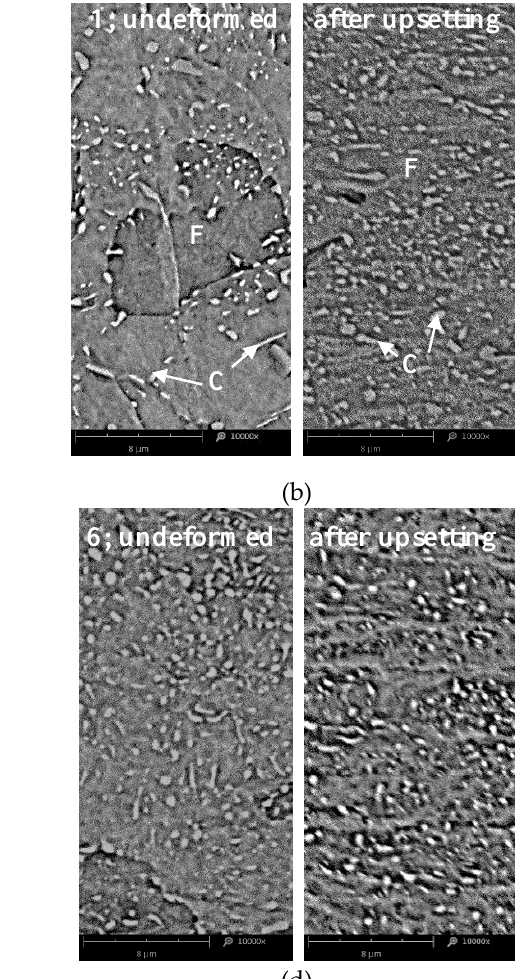
Figure 5. Transverse macrostructure of a half-view of the upset sample: ( a ) sample no. 0 and ( b ) annealed sample no. 6. Materials 2020 , 13, x FOR PEER REVIEW